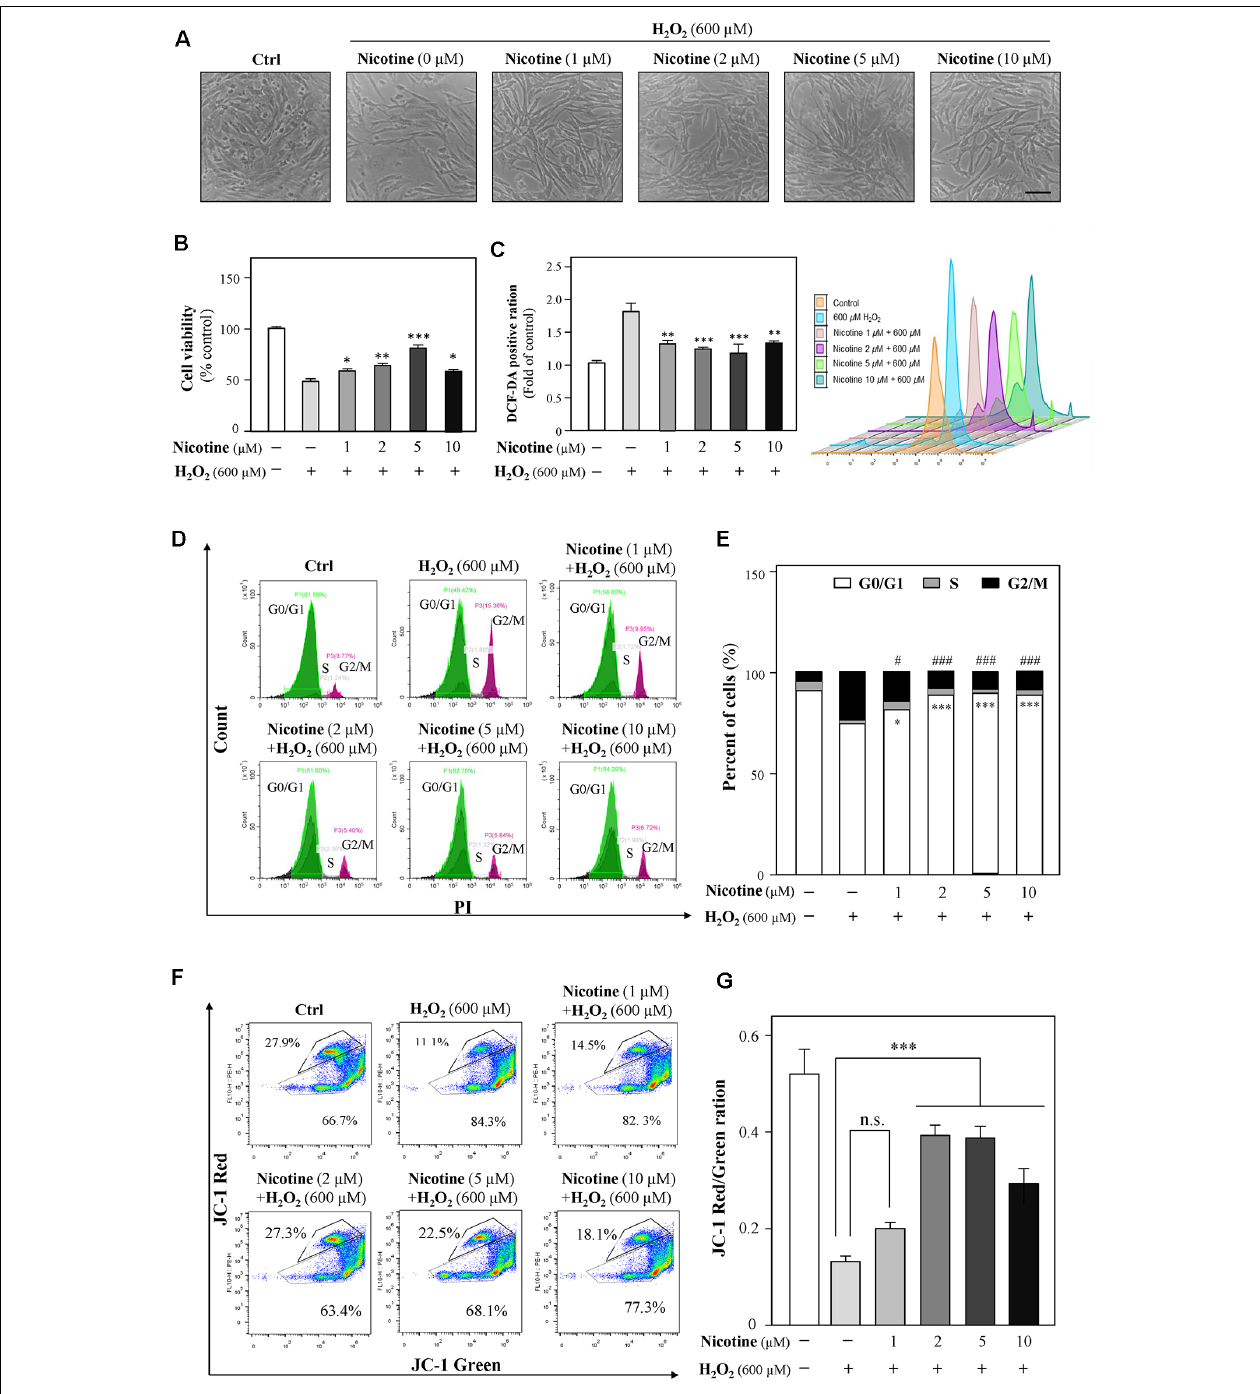
FIGURE 4 | Nicotine suppresses the H 2 O 2 -induced oxidative injury in HT-22 cells. Cultured HT-22 cells were seeded in six-well plates and incubated in different concentrations of nicotine (1, 2, 5, and 10 µ M) for 24 h, followed by the application of H 2 O 2 (600 µ M) for another 24 h; the control group consists of the untreated cells. (A) Representative images of the cell morphology. Bar = 100 µ m. (B) Cell viability test was performed using CCK-8 kit, and the changes were shown in histograms as percentage with control. (C) The amount of intracellular ROS was detected by DCFH-DA using flow cytometry. Mean fluorescence density of the ROS level was calibrated. (D) The cell cycle was detected by flow cytometry with Annexin V/PI apoptosis detection kit using a flow cytometer. (E) Values are in percentage of apoptotic cell rates of live cells, apoptotic cells, and dead cells, as calibrated from panel (D) . (F) Representative dot plot of the changed mitochondrial membrane potential using flow cytometry after labeling the fluorescent probe with JC-1. (G) Ratios of JC-1 red/green were shown in histograms. All data in the bar charts represent mean ± SEM, n = 3. ∗ p < 0.05, ∗∗ p < 0.01, ∗∗∗ p < 0.001, and # p < 0.05, ### p < 0.001 vs. control group. n.s., no significance.